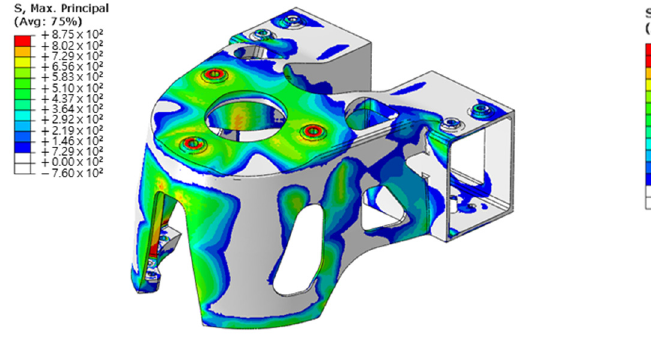
Figure 13. Results of finite element analysis: ( a ) result of maximum stress in the principal axis di- rection; ( b ) location of stress in excess of tensile strength.